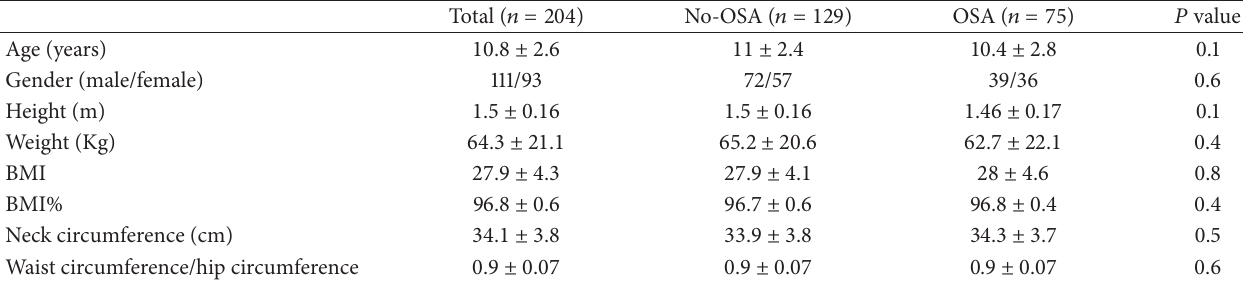
Table 1: Antropometric measures in OSA and no-OSA obese children.